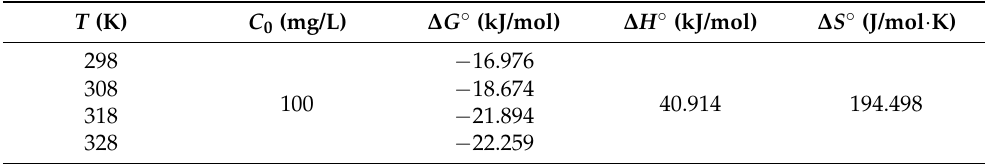
Table 5. The thermodynamic parameters of the adsorption.